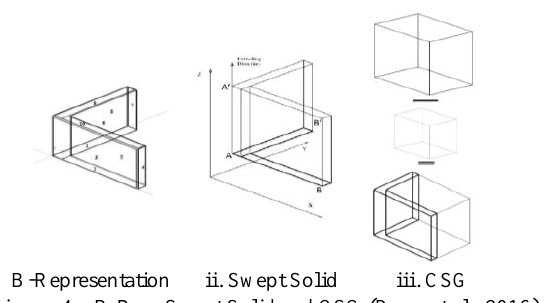
Figure. 4. B-Rep, Swept Solid and CSG (Deng et al.,